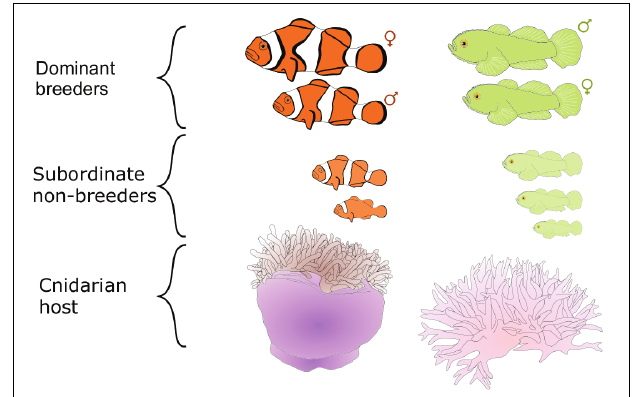
FIGURE 1 | Schematic of the social organization of Amphiprion percula (left) and Paragobiodon xanthosoma (right)